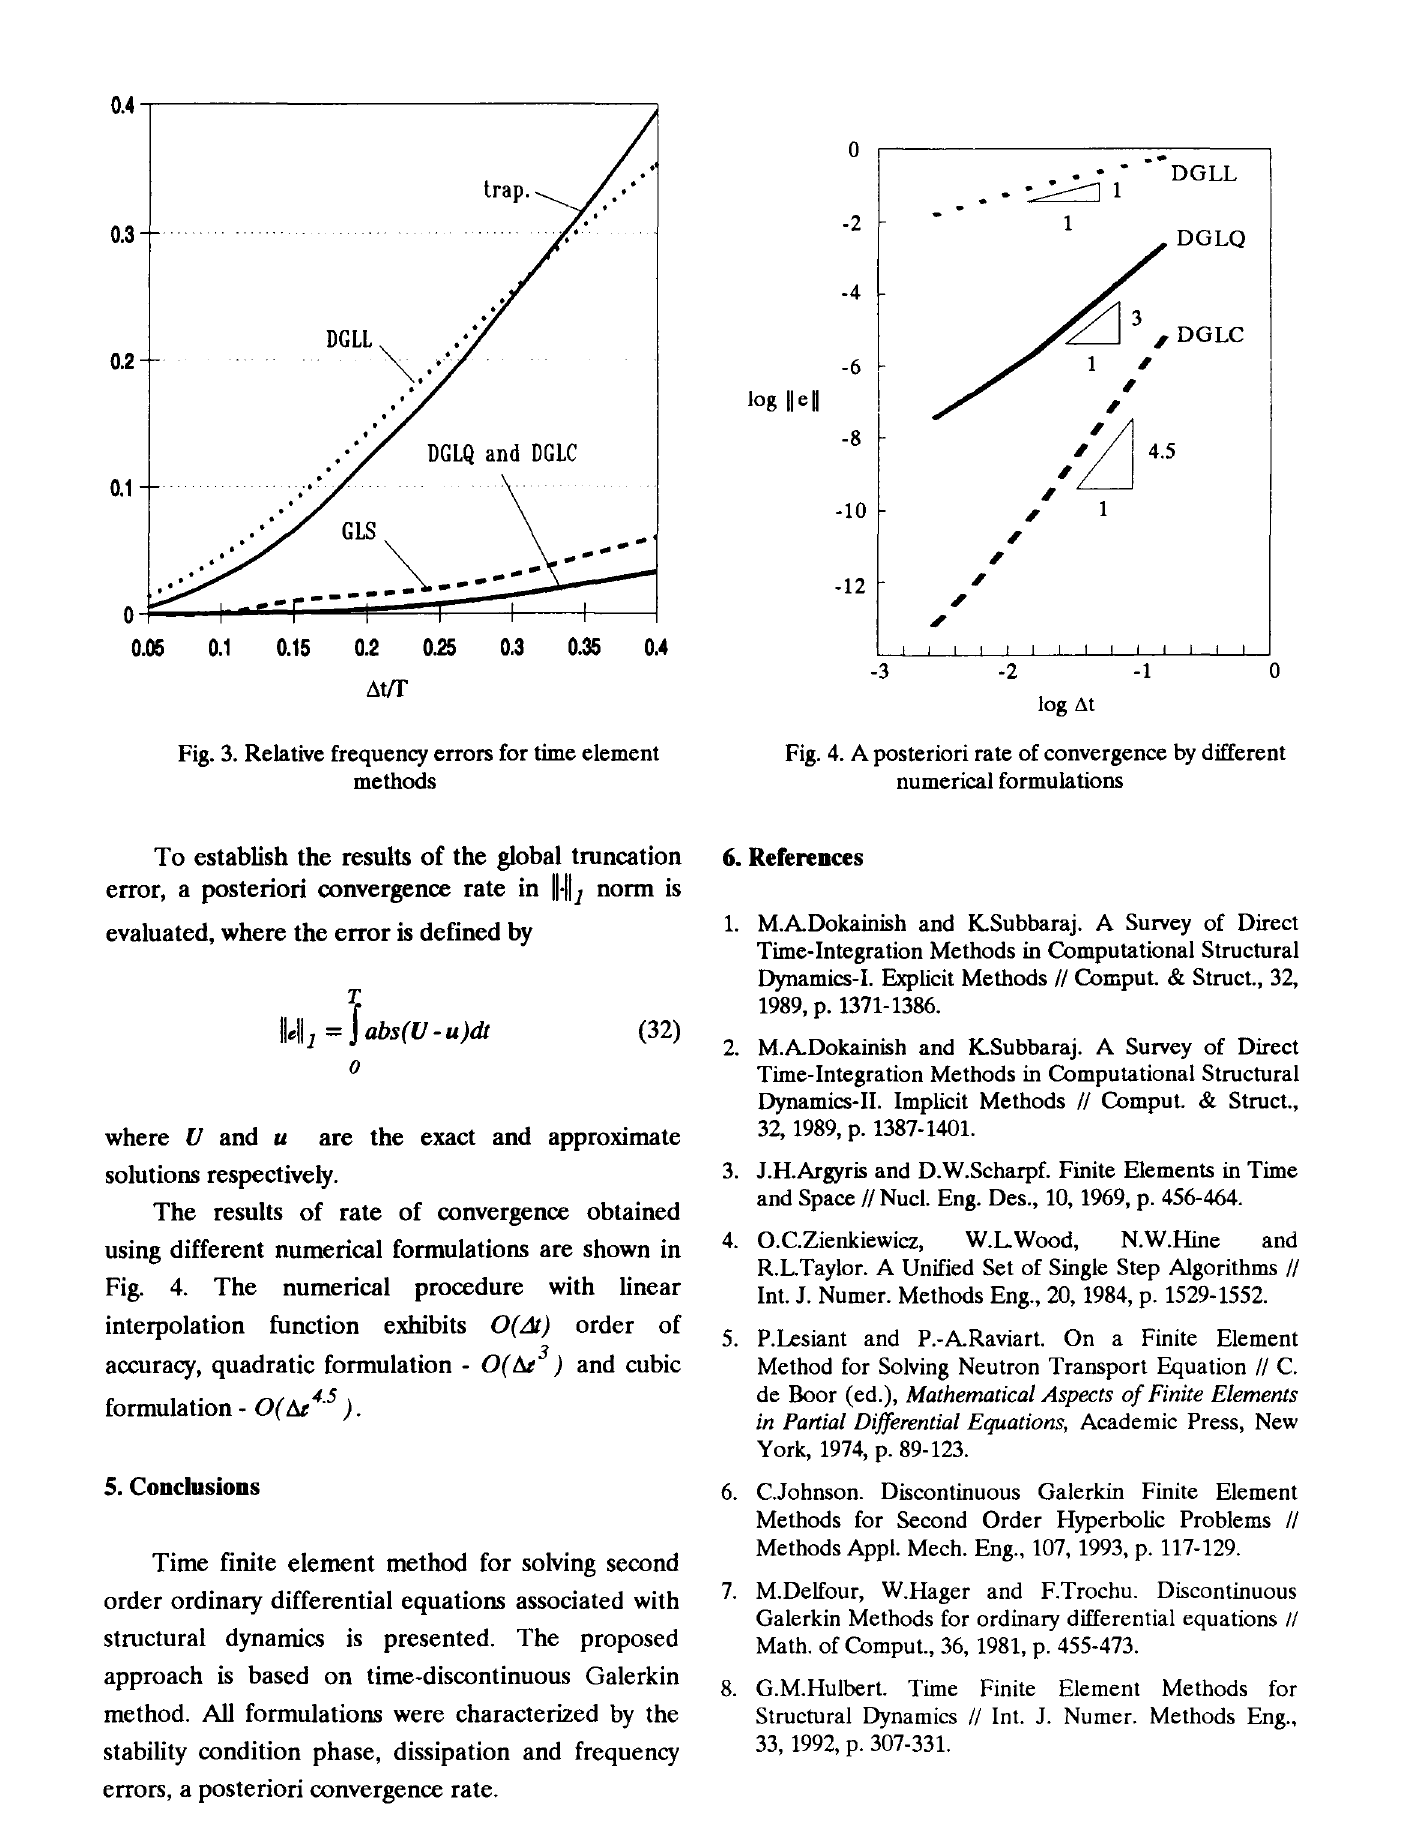
Fig. 4. A posteriori rate of convergence by different numerical